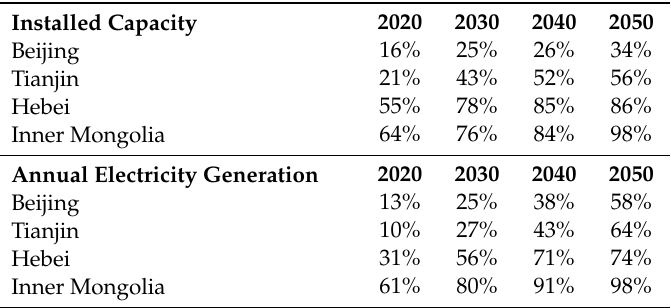
Table 9. Solar and wind share of energy in terms of installed capacity and annual generation (with the consideration of curtailment) by model region.